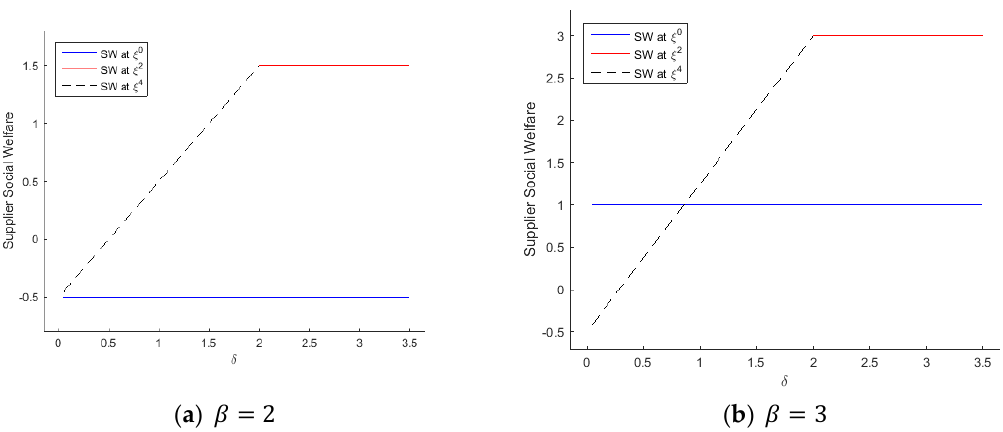
Figure 5. Suppliers ’ SW changes as the backward compatibility ( 𝛿 ) varies. Figure 5. Suppliers’ SW changes as the backward compatibility ( δ ) varies.